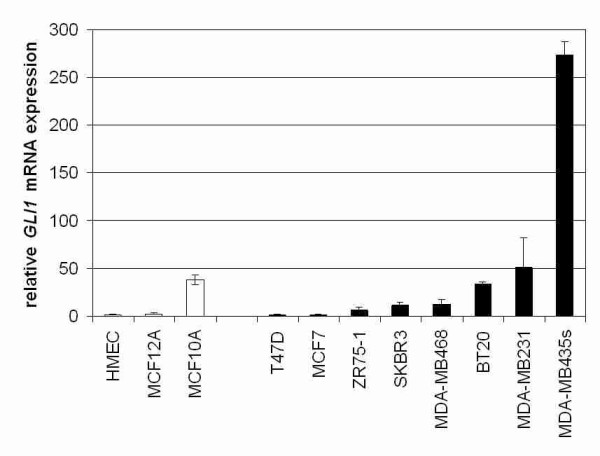
Elevated expression of GLI1 mRNA in breast cancer cell lines. Semiquantitative realtime PCR (Light Cycler) analysis for GLI1 expression was performed on reverse transcribed RNA extracted from non-malignant (grey bars) and malignant breast cell lines (black bars). Expression data were related to GLI1 mRNA expression in the human mammary epithelial cell line HMEC (set to 1). In five of eight analysed malignant mammary cell lines (SKBR3, MDA-MB468, BT20, MDA-MB231 and MDA-MB435s) increased levels of GLI1 mRNA expression were found. GLI1 mRNA expression in normal human epithelial mammary cell lines HMEC and MCF12A cells is relatively low, except for cell line MCF10A which also presents abundant GLI1 expression.